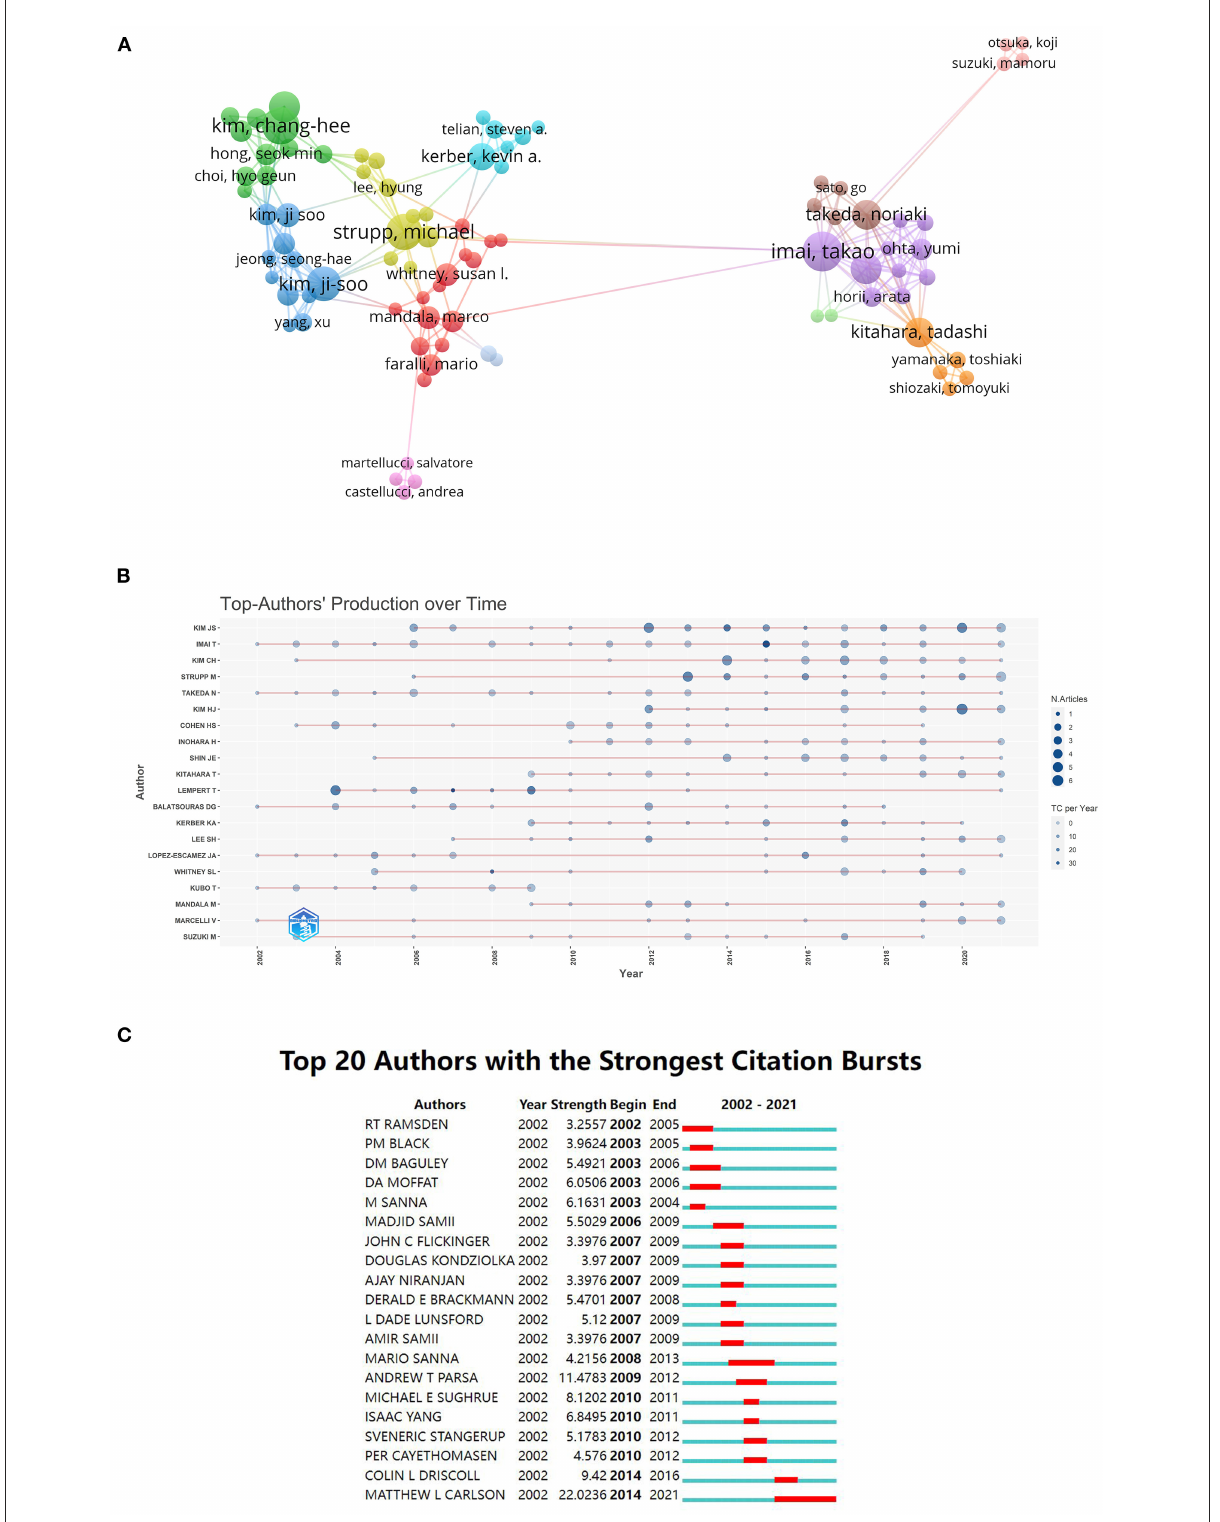
FIGURE4 (A) A network visualization map of co-authorship in BPPV research from 2002 to 2021. (B) The top-20 productive authors in the field over time. (C) The top-10 authors with the strongest citation bursts